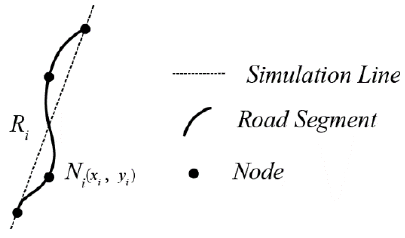
Figure 2. Calculation of declination rate.